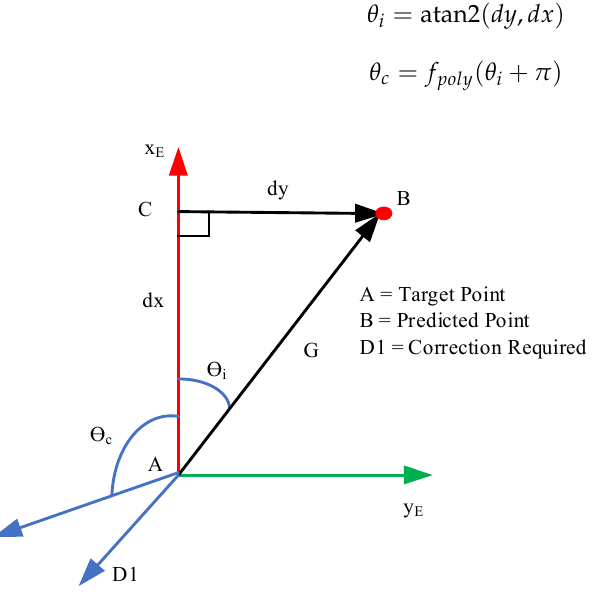
Figure 15. Predicted Impact Point Deviation and Magnitude.